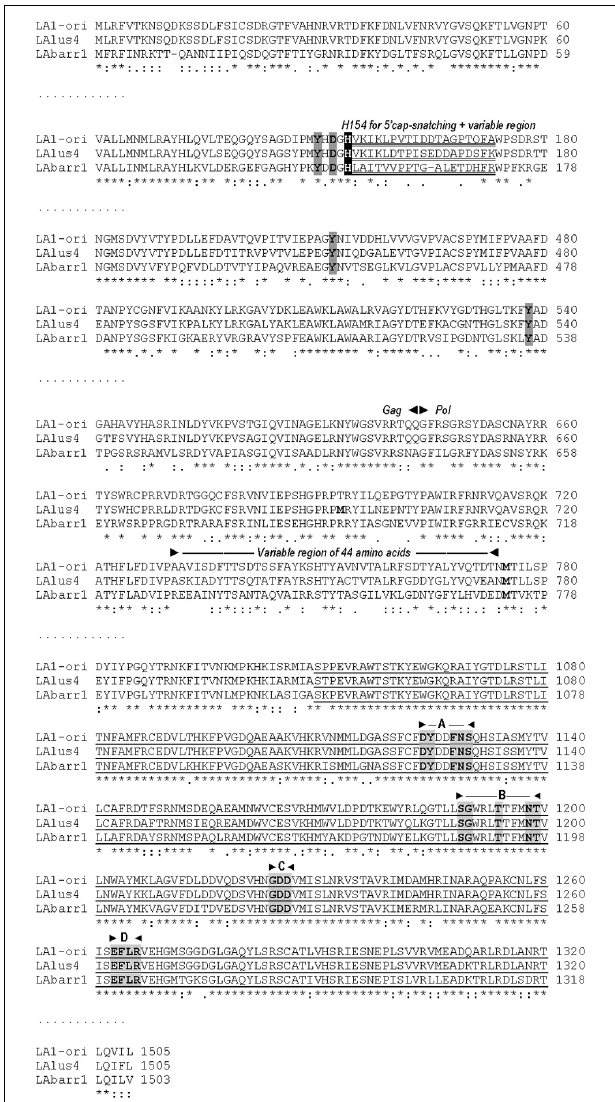
FIGURE 2 | Comparison between partial amino-acid sequences of Gag-Pol encoded by ScV-LA-original, ScV-LAlus4, and TdV-LAbarr1 dsRNA genomes. The full sequence alignment is presented in Supplementary Figure S2 . The separation between Gag and Pol is indicated (Gag ◄► Pol). The H154 residue required for 5 (cid:48) cap-snatching is black shaded. The stretch of variable amino-acid sequence located downstream from H154 is double underlined. The four crucial residues for cap recognition (Tyr-150, Asp-152, Tyr-452, and Tyr-538) are gray shaded. A variable region of 44 amino acids in the N-terminal region of Pol is indicated above the sequence. The highly conserved central third of Pol is underlined, and the four consensus motifs (A–D) conserved in RNA-dependent RNA polymerases from totiviruses are indicated above the sequence, and the conserved amino acids for each motif are gray shaded. Methionines (M) in the N-terminal region of Pol are in boldface. Asterisks (*) indicate identical amino acids; colons (:) and single dots (.) indicate conserved and semi-conserved amino acids,